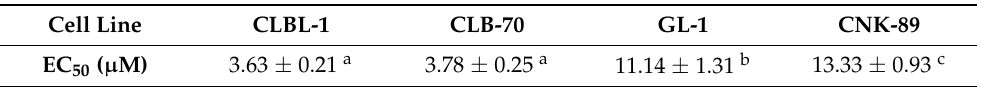
Figure 1. Comparison of the cytotoxic effect of benzyl isothiocyanate (BITC) on noncancerous and canine cancer cell lines. The cells were exposed to increasing concentration of BITC for 24 h. Cell viability was assessed by cytometric analysis following propidium iodide (PI) staining. The values are means ± SD of three independent experiments. * Considered significant in comparison with control ( p < 0.05). Table 1. EC 50 values for BITC in four canine cancer cell lines after 24 h incubation. The values are means ± SD of three independent experiments. a,b,c Values with different letters in the superscript differ statistically ( p <